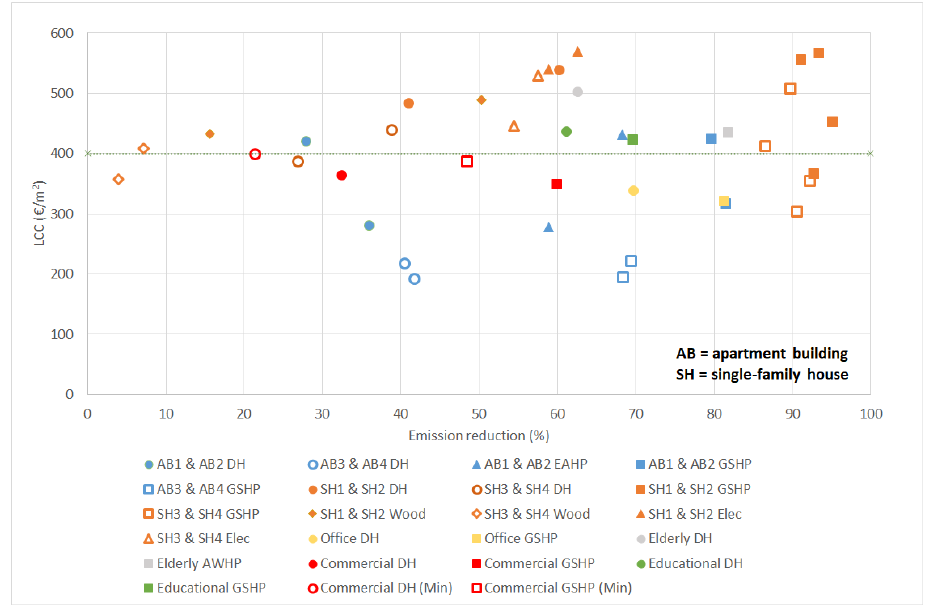
Figure 6. Life cycle cost (LCC) versus emission reduction as a percentage relative to unrenovated reference cases.